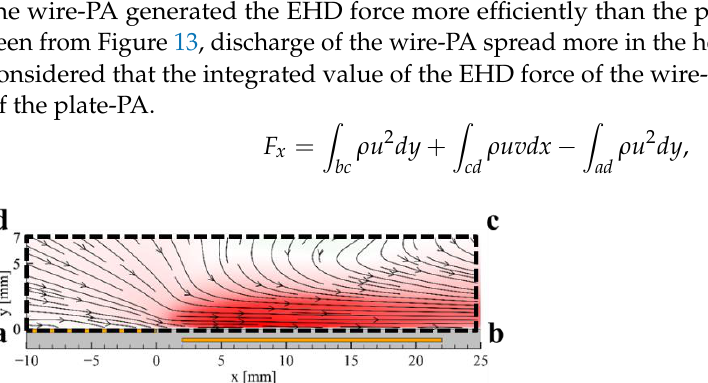
Figure 20. Control volume for the momentum conservation equation.